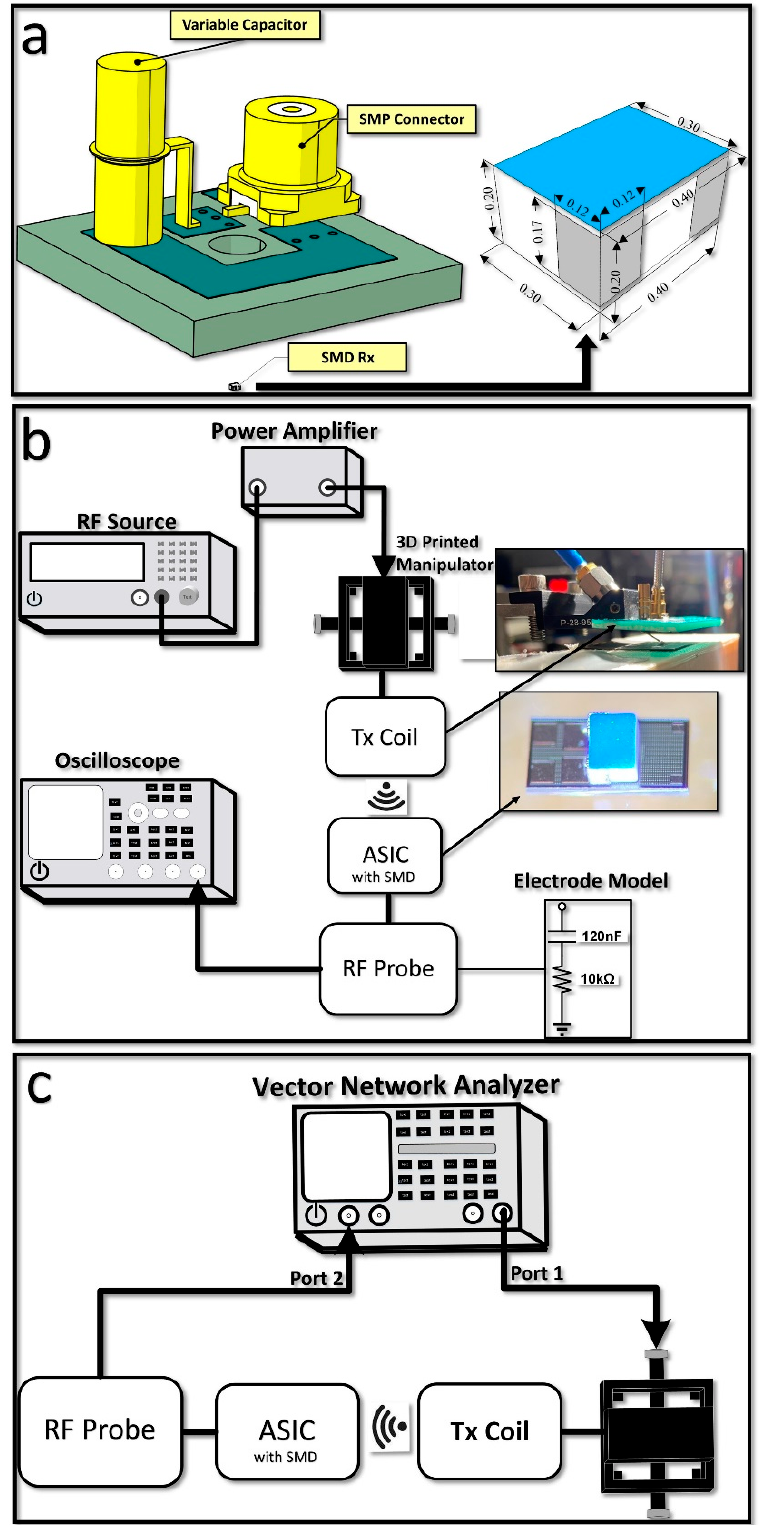
Figure 3. ( a ) HFSS simulation model of the wireless power link, ( b ) drawing/picture of the experi- mental setup used to measure the rectified voltage, and ( c ) drawing of the experimental setup used to measure the S 12 , S 11 , and S 22 parameters. For both testbench setups, the Tx–Rx distance was set to 5 mm.